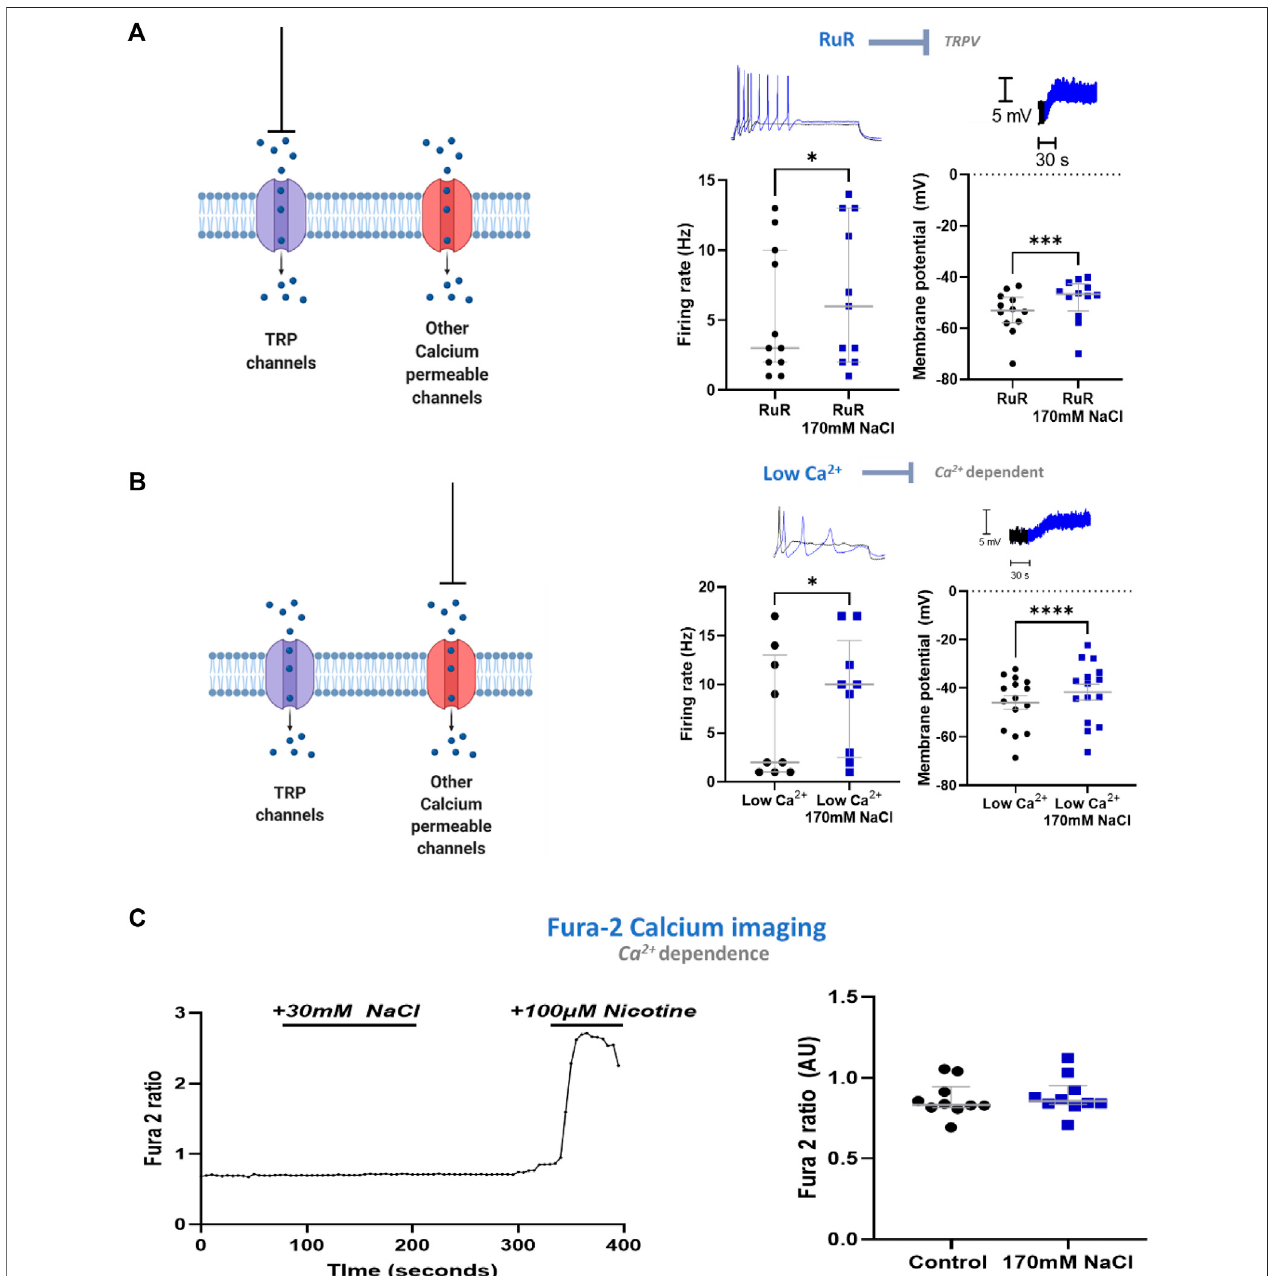
FIGURE 4 | The excitatory response to NaCl is independent of Ca 2+ in stellate ganglia neurons. (A) TRPV channel inhibition by ruthenium red does not prevent the effects of high NaCl. TRPV inhibitor ruthenium red (10 µM) did not prevent 170 mM induced increased maximum fi ring frequency (3 Hz – 6 Hz, Wilcoxon matched-pairs test, p = 0.02) nor membrane depolarization (5.14 ± 1 mV, Paired t -test, p = 0.0003). (B) Reducing external Ca 2+ from 1.8 mM to 0.2 mM did not prevent the effect of 170 mMNaCl. Whenrecording inlowCa 2+ Tyrode ’ ssolution170 mMNaCl stillincreasedneuronal fi ring(2Hz – 10 Hz;n=9;Wilcoxontest; p =0.031)and evoked membrane depolarization in sympathetic stellate ganglia neurons (4.32 ± 0.72 mV; n = 15; Paired t -test; p < 0.0001). For the raw data trace, low extracellular Ca 2+ concentration withphysiological[NaCl] o isshown inblack, lowextracellularCa 2+ concentrationwith170 mM [NaCl] o isshown inblue. (C) High[NaCl] o doesnotevoke a Ca 2+ response in stellate ganglion neurons. 170 mM [NaCl] o evoked no signi fi cant intracellular Ca 2+ response in sympathetic stellate ganglia neurons as assessed by Fura-2 live-cell Ca 2+ imaging ( n = 10; Paired t -test; p = 0.066). Control recordings were taken as the average between 20 – 60 s of recording, the response was taken as thepeakvaluebetween80 – 200 sofrecording.Nicotinewasaddedtodemonstratethatthetestedstellateganglianeuronswereresponsivetoexternalstimuli.Alltested neurons had a nicotinic response comparable to that shown here.